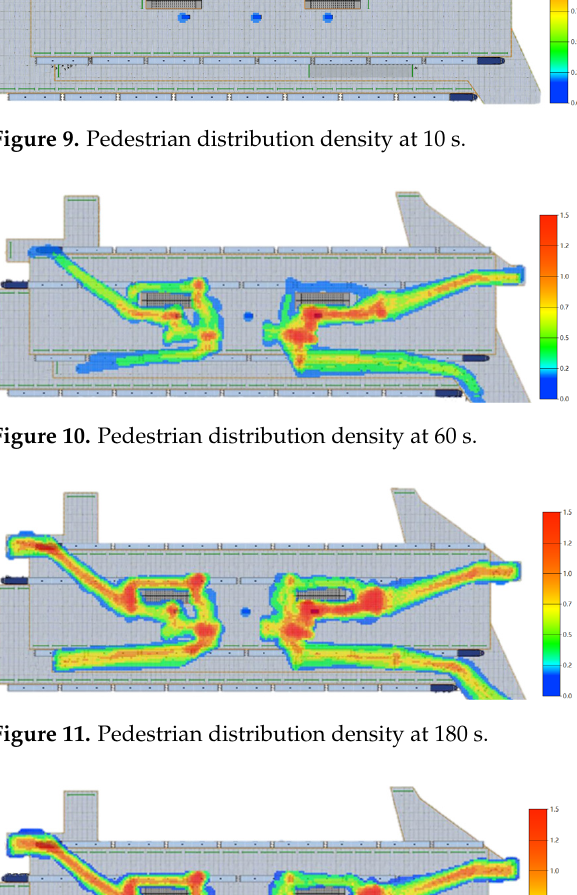
Figure 13. Pedestrian distribution in 3D view at 10 s. Figure 14. Pedestrian distribution in 3D view at 60 s. The 3D view shows that, at the beginning of the evacuation (10 s), some pedestrians had just got off the train, while a large number of people on the platform apparently gath- ered at the entrance of the escalator. Within 240 s, many pedestrians had fled to the lobby floor and apparently gathered at the door. After all pedestrians on the lobby floor fled, the evacuees began to flee the scene. The above analysis found that the high density of people at the stairs and doorways was the bottleneck factor in the whole evacuation process. Therefore, the influence of dif- ferent factors on the emergency evacuation speed was analyzed by varying the personnel structures, the width of the evacuation stairs, and the number of gates.